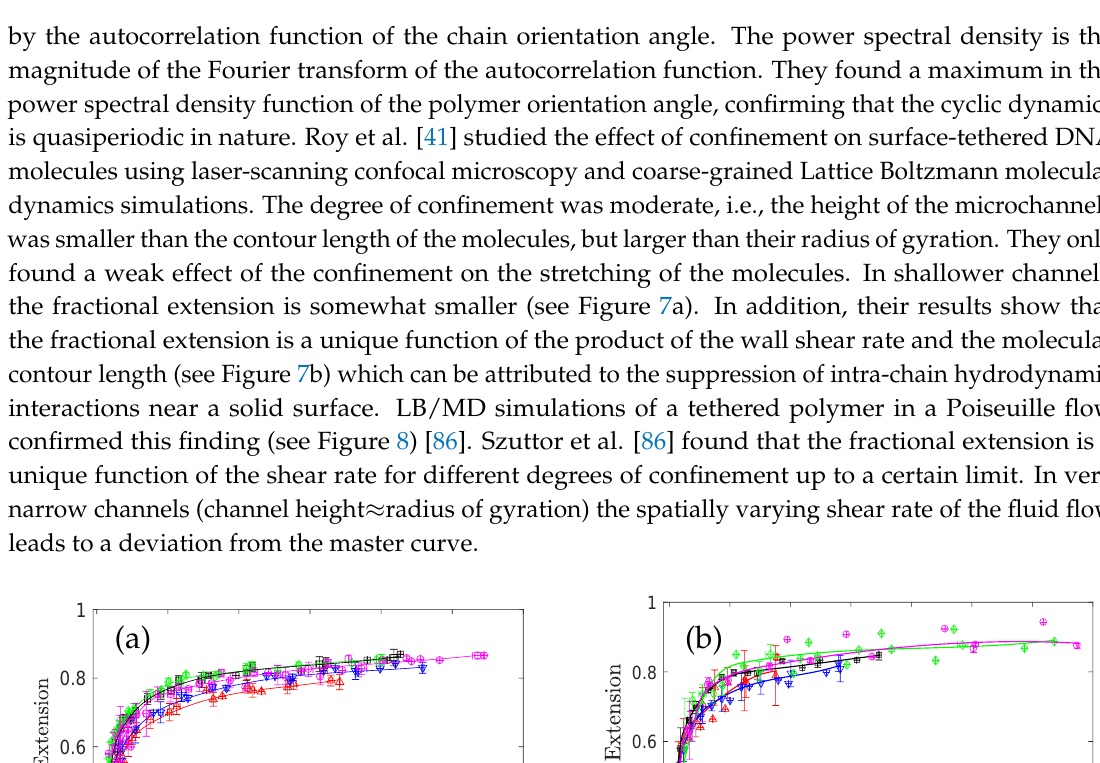
(b) Figure 6. Experimental results obtained by Ladoux and Doyle [25]. (a) Mean fractional chain extension vs. Weissenberg number (Wi): L = 18.9 µ m (squares), L = 37.8 µ m (triangles), and L = 56.7 µ m (circles). (b) Comparison of the experimental data to scaling laws resulting from the worm-like chain,